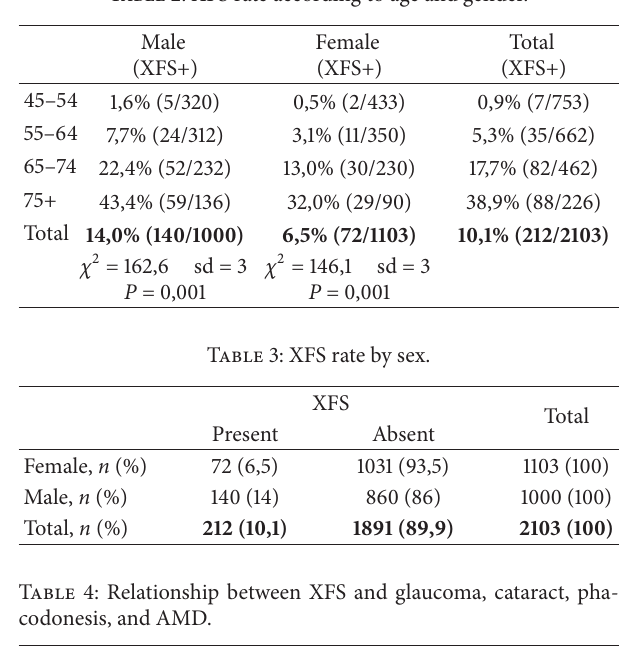
Table 1: XFS-related factors. Table 2: XFS rate according to age and gender.